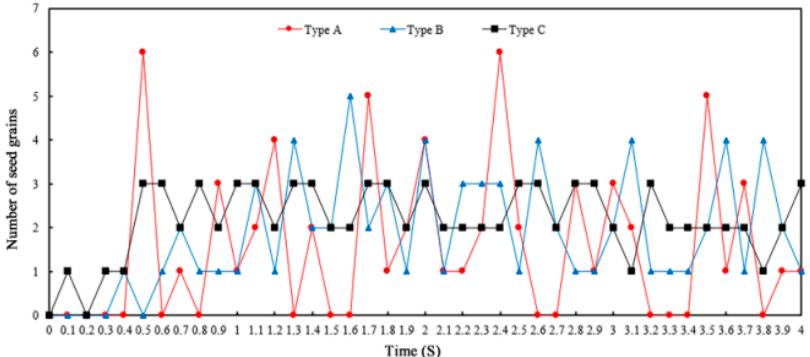
Figure 3. Variation of the number of discharged seeds from the feeding device with time for different types of wheels.